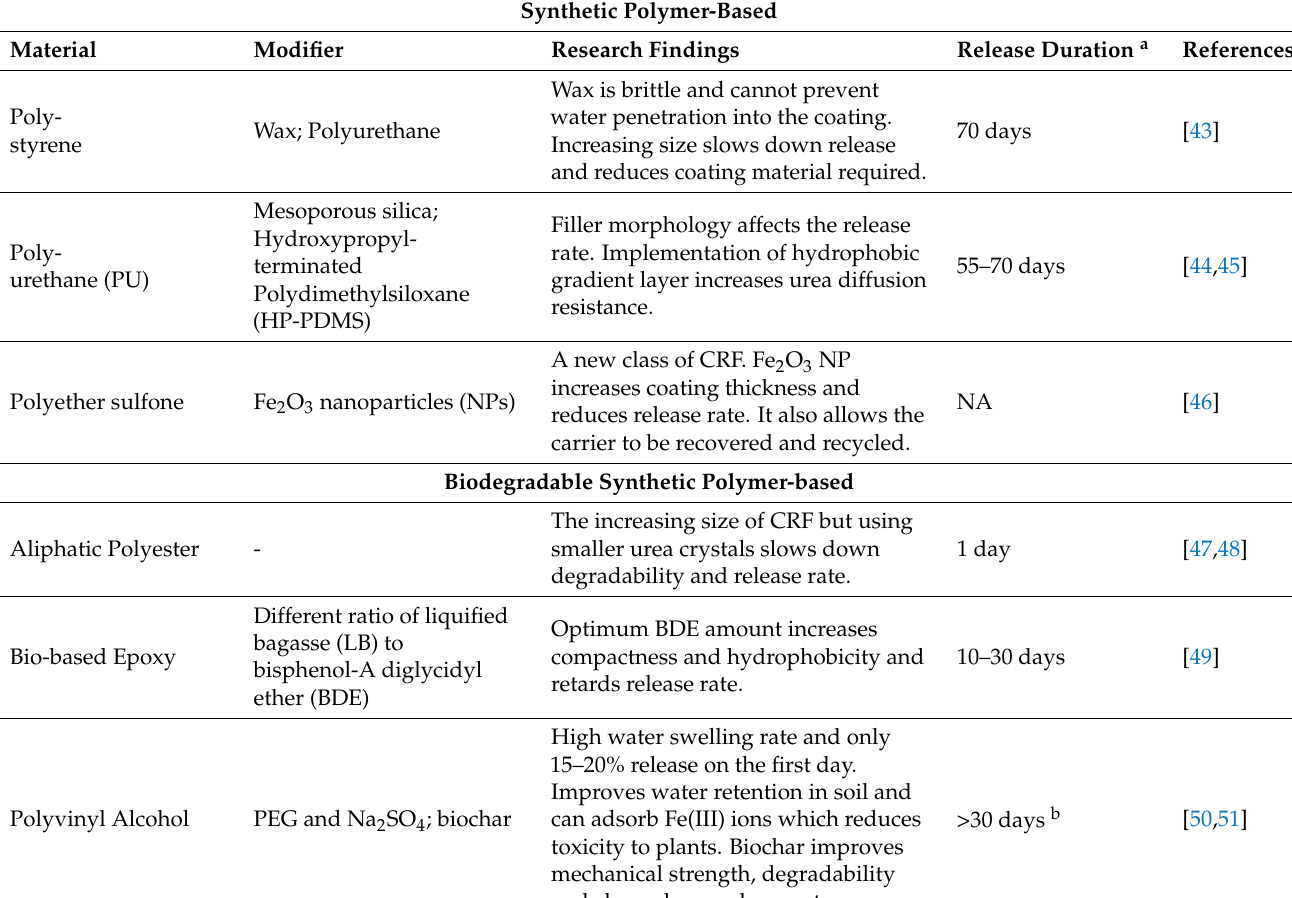
Table 2. Synthetic polymer-based